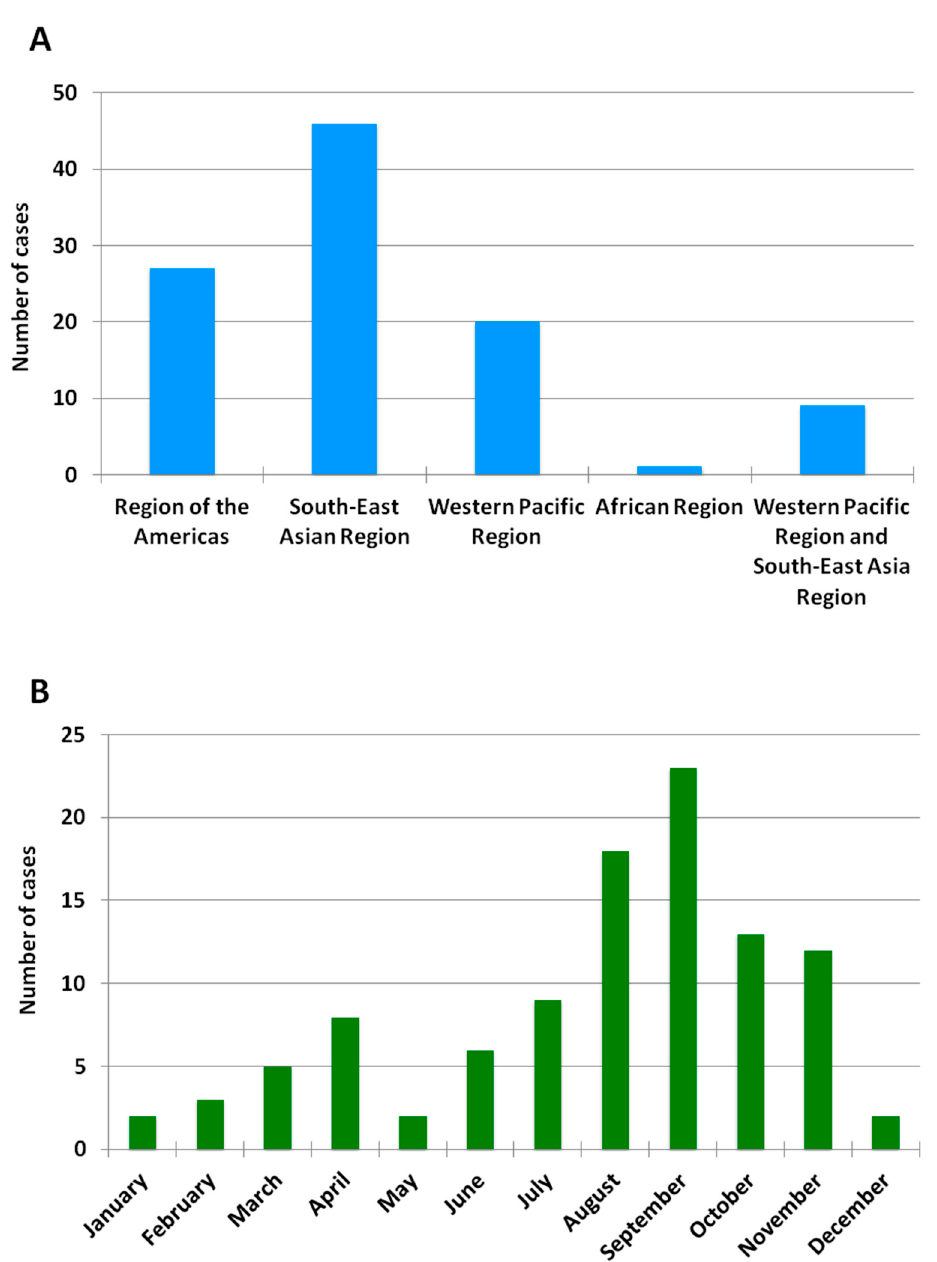
Figure 2. Geographic and monthly distribution of RT-PCR-positive imported dengue cases. ( A ) Number of imported RT-PCR-positive dengue cases by WHO region between 2013 and 2018. No cases were detected in travelers returning from the Eastern Mediterranean Region or the European Region. ( B ) Number of imported RT-PCR-positive dengue cases by month between 2013 and 2018.